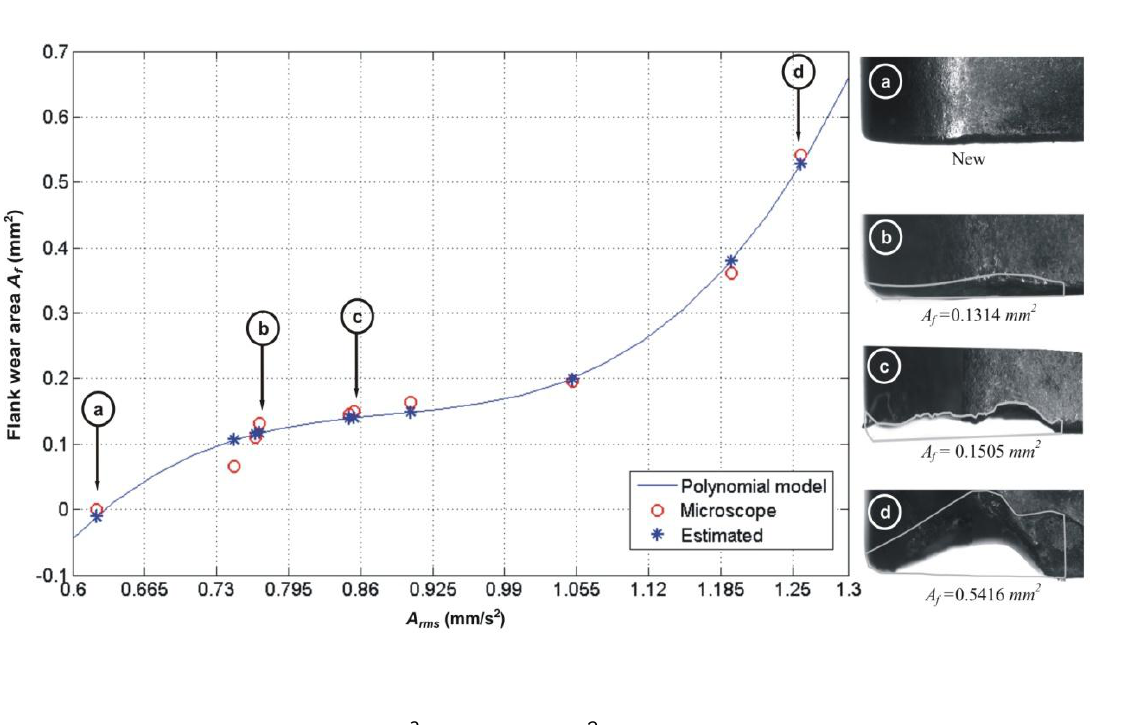
Figure 8. Flank-wear area estimation based on vibration